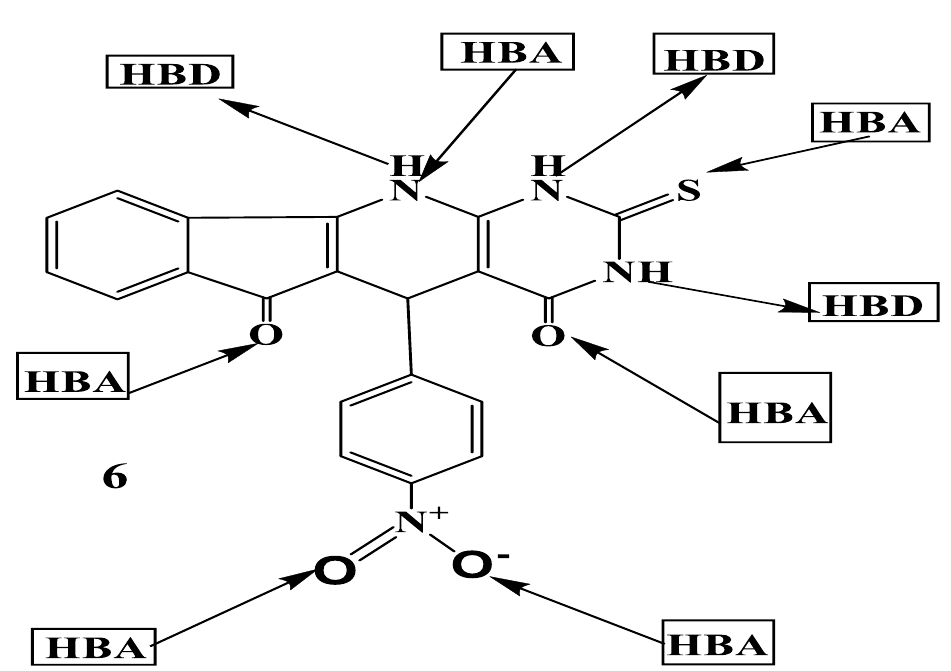
Figure 7. Hydrogen bond donor (HBD) and hydrogen bond acceptor (HBA) sites of compound 6H .